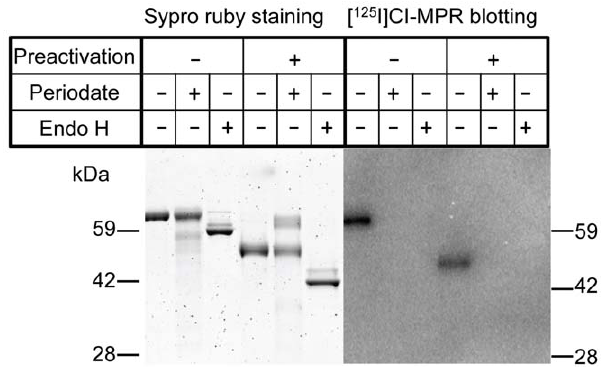
Figure 1. Reducing SDS-PAGE analysis of native and carbohy- drate modified TPP1. Left panel: Sypro ruby stained gels. Right panel: Blots probed with soluble I 125 -CI-MPR. Note that Endo H treatment results in a shift of , 6 KDa, consistent with removal of N - linked oligosaccharides.